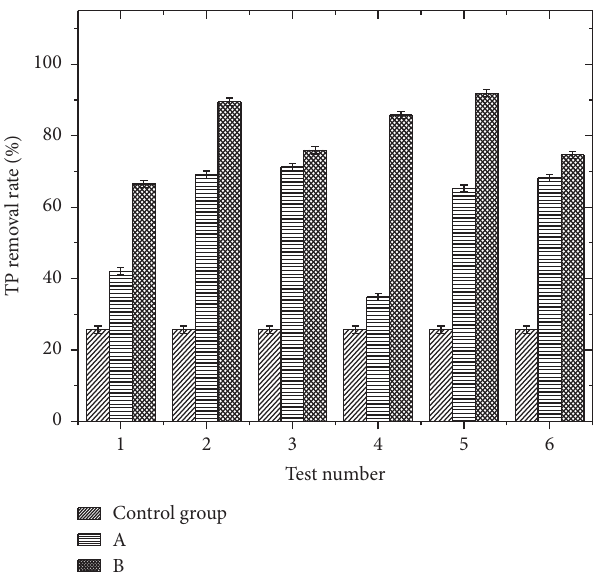
Figure 6: SS purification effect of permeable concrete. Note: A- 1 ∼ A-6: permeable concrete specimens with unmodified diatomite and zeolite powder in different dosages; B-1 ∼ B-6: permeable concrete specimen with modified diatomite and zeolite powder in different dosages.